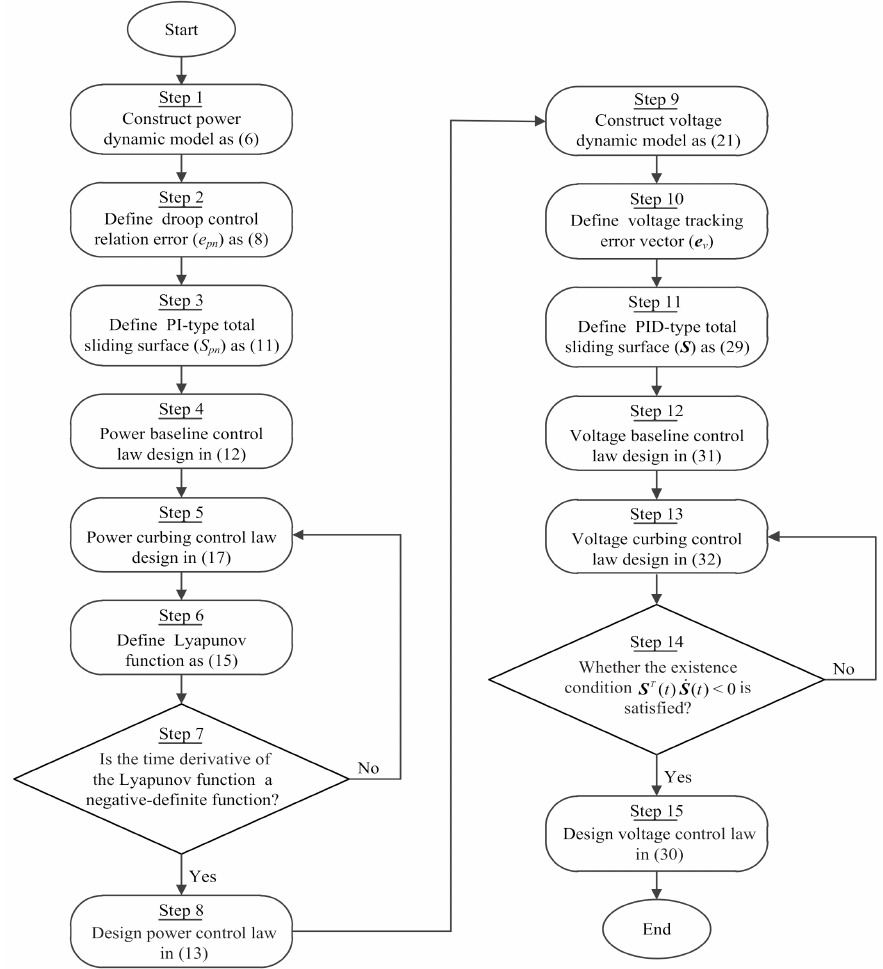
Figure 3. Design flowchart of proposed total sliding-mode control (TSMC)-based control